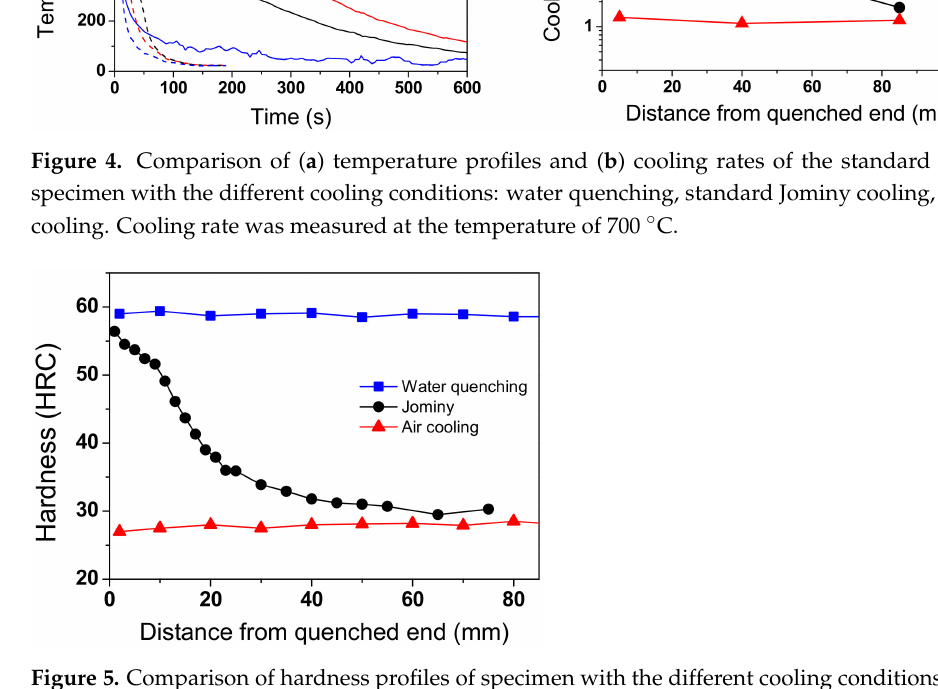
Figure 5. Comparison of hardness profiles of specimen with the different cooling conditions: water quenching, standard Jominy cooling, and air